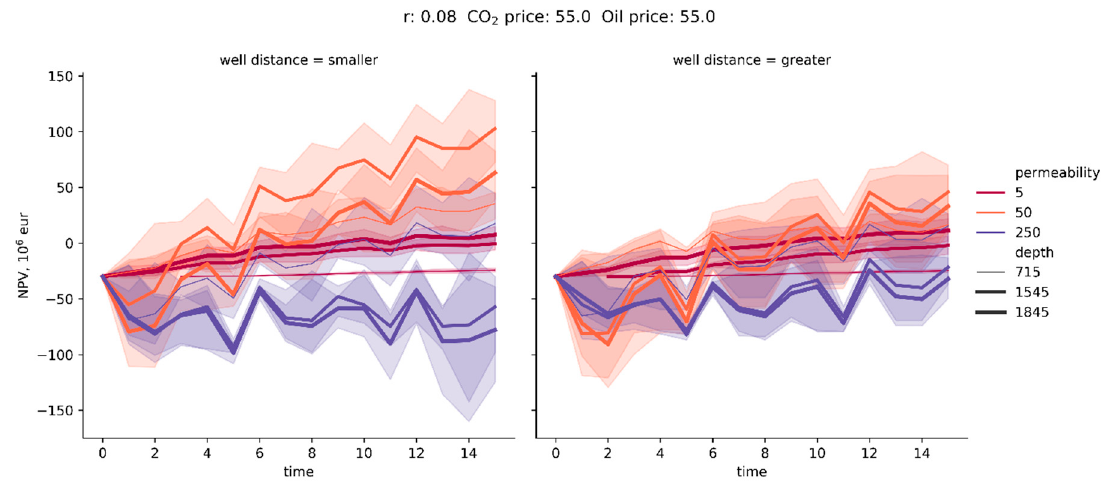
Figure A4. Time versus NPV for the optimistic scenario with 20 €/MWh electricity price.